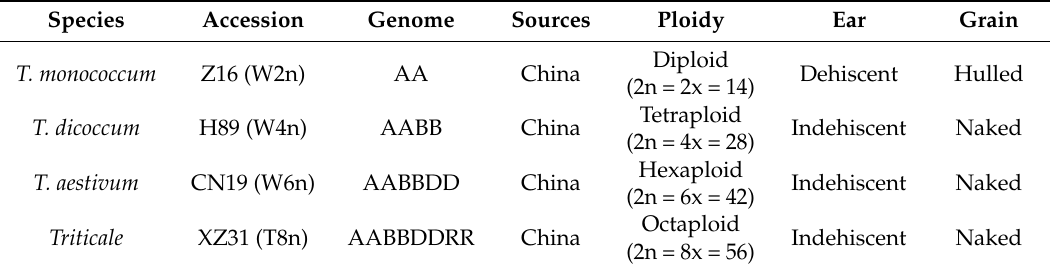
Table 3. Details of species, accession, source, ploidy level, genome, ear and grain characteristics, and origin of genetic materials used in the